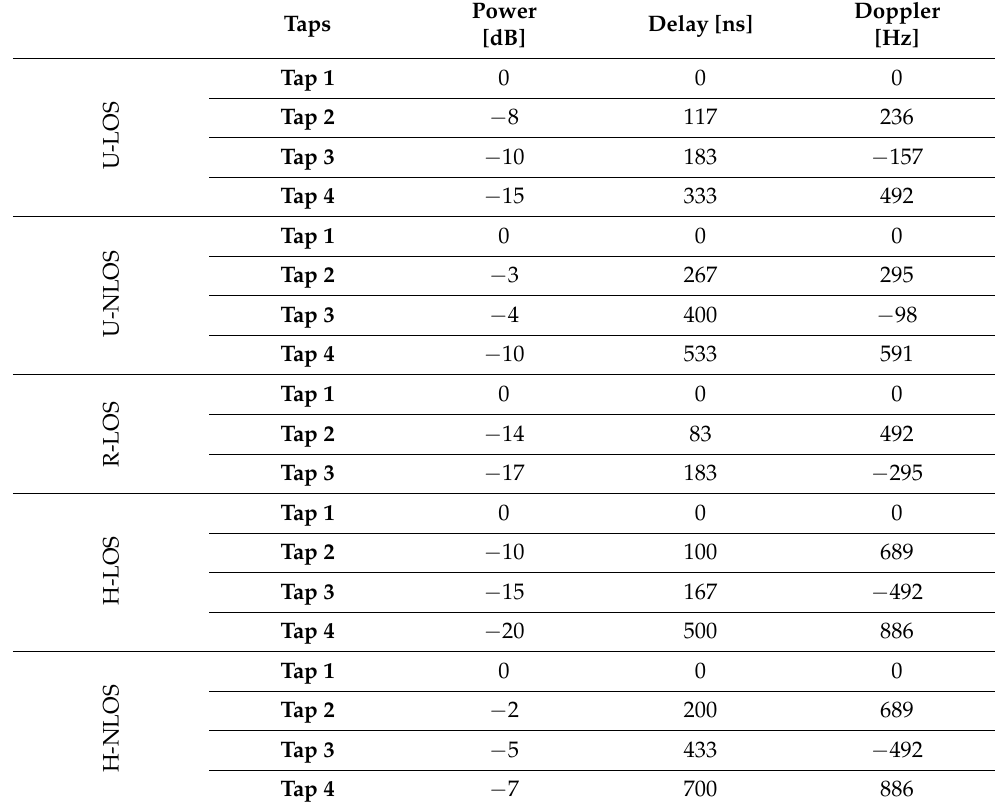
Table 1. Vehicular environment